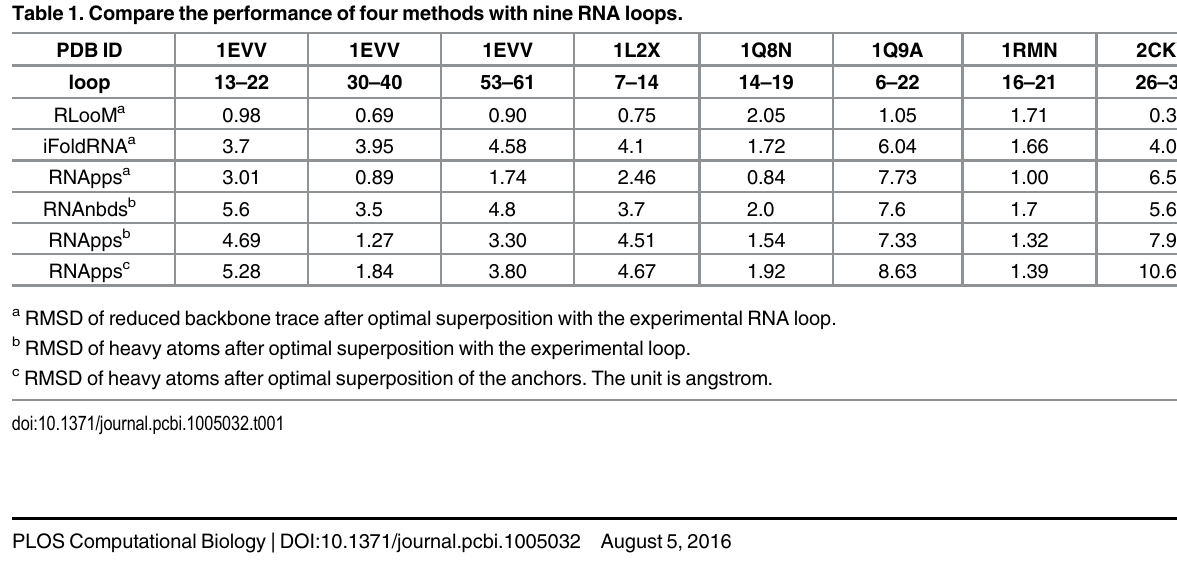
Table 1. Compare the performance of four methods with nine RNA loops.